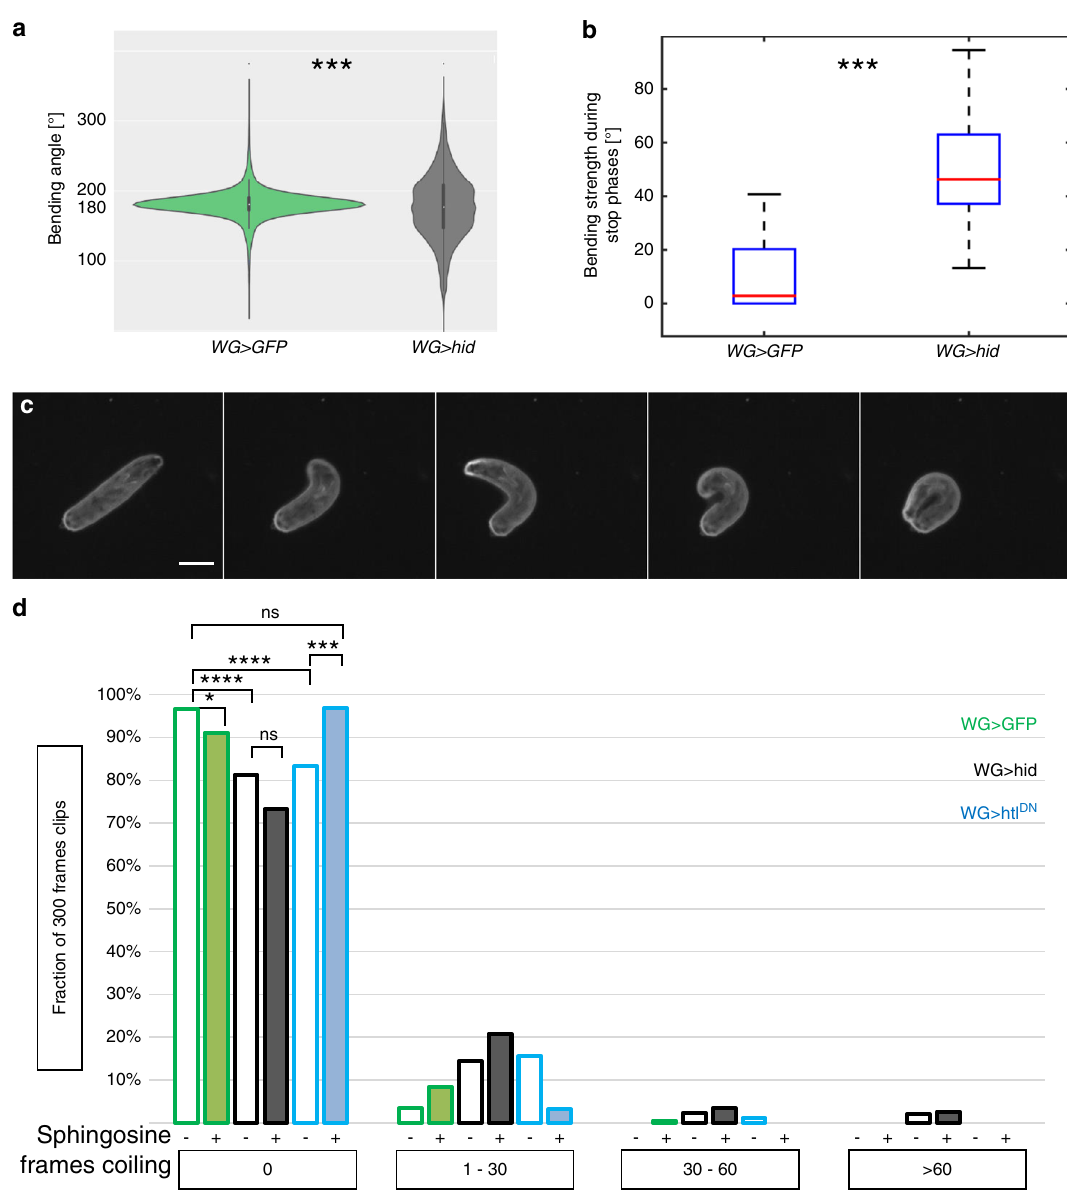
Fig. 7 Coiling behavior upon wrapping glia ablation. a Graph showing all bending angles of control [ nrv2-Gal4/UAS-GFP; 90C03-Gal80, UAS-CD8Cherry/ 90C03-Gal80 ] and wrapping glia ablated larvae [ nrv2-Gal4/UAS-hid; 90C03-Gal80, UAS-CD8Cherry/90C03-Gal80 ] ( p = 1.8E − 244, t test). A bending angle of 180° corresponds to a non-bended larva. b Box plot shows bending strength [°] during stop phases. Control animals show a median bending angle of around 3°, while Hid expressing animals show a median bending angle of around 47° ( p = 6.8E − 37, Wilcoxon rank-sum test). Genotypes as in ( a ). n = 91 control larvae, and n = 79 wrapping glia ablated larvae. Box plot shows median (red line), boxes represent the fi rst and third quartile, whiskers show standard deviation, red points show outliers. c Five frames of a movie showing coiling of a larva with ablated wrapping glia (genotype as in a ). Representative example out of 150 coiling events analyzed. Scale bar is 1 mm. d Relative changes in coiling behavior. The following genotypes were analyzed: Control (green), wrapping glia ablation (black), genotypes as in ( a ), and larvae expressing htl DN in wrapping glia (blue) [ nrv2-Gal4, UAS-htl DN ; 90C03-Gal80/90C03-Gal80 ]. The proportion of 30 s long video clips (300 frames) showing no coiling, 1 – 30 frames, 30 – 60 frames, or more than 60 frames with coiling are plotted. Filled bars indicate animals that were fed with sphingosine. In control larvae coiling is observed in 0.097% of all frames ( n = 657 video clips of 300 frames each). Upon feeding with sphingosine, coiling frequency increases in control animals to 0.356%, ( n = 203, p = 0,0474). Upon wrapping glia ablation, coiling is noted in 1.507% of all frames ( n = 557). Upon feeding with sphingosine coiling frequency does not change signi fi cantly to 2.166%, ( n = 269, p = 0,2653). Larvae expressing htl DN in wrapping glia show coiling in 0.774% of all frames ( n = 263). Upon feeding with sphingosine, coiling frequency decreases signi fi cantly to 0.106% ( n = 223, p = 0.0001) which is not distinguishable from the coiling frequency of control animals (0.097%, p = 0.4209). Statistical analyses: Wilcoxon rank-sum